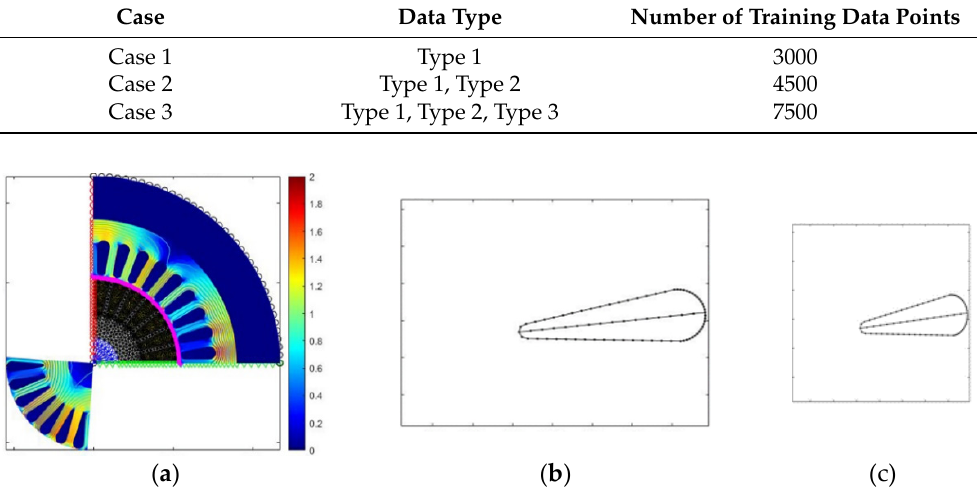
Figure 4. Preprocessing process of simulation data; ( a ) simulation data ( b ) rotor slot image (875, 656)